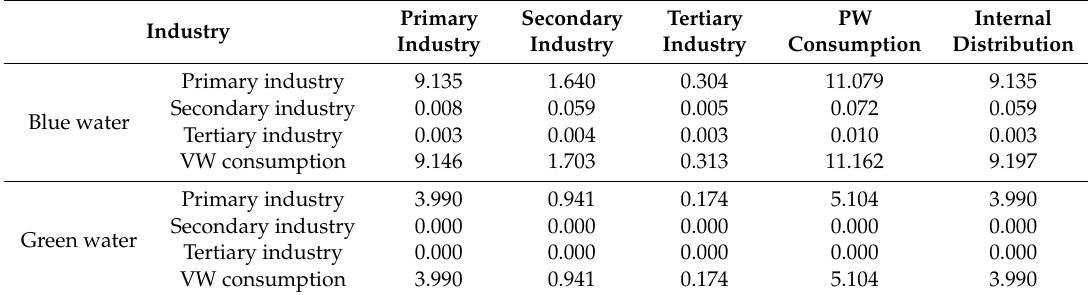
Table 1. Virtual water reallocation matrix among industries in NTM (Unit: km 3